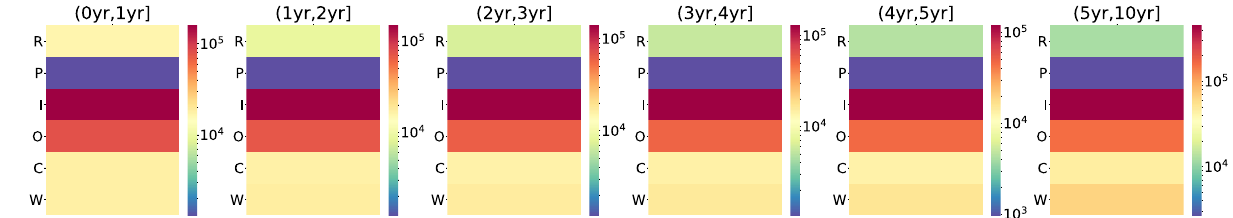
Figure 3. The number of 2-event motifs in the opposition network using different timing thresholds. Each row represents a type of 2-event motif; see the caption of Fig. 2 for the abbreviation. The color indicates the motif counts. For each heat map ( x , y ], we only count the motifs of which the inter-event time is larger than x and not greater than y .